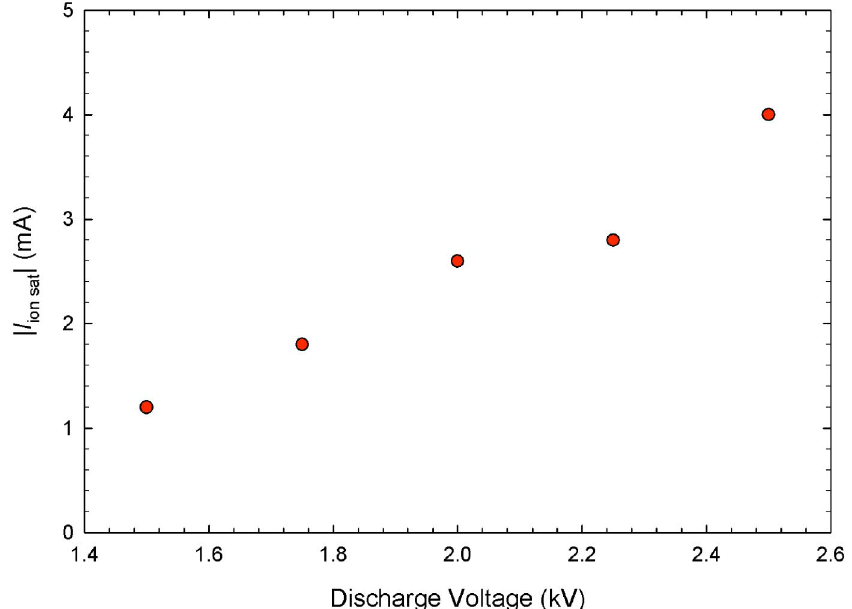
FIG. 28. (Color) Ion saturation current as a function of the NTX cathode-arc discharge voltage. The plasma density varies proportionally with this current.